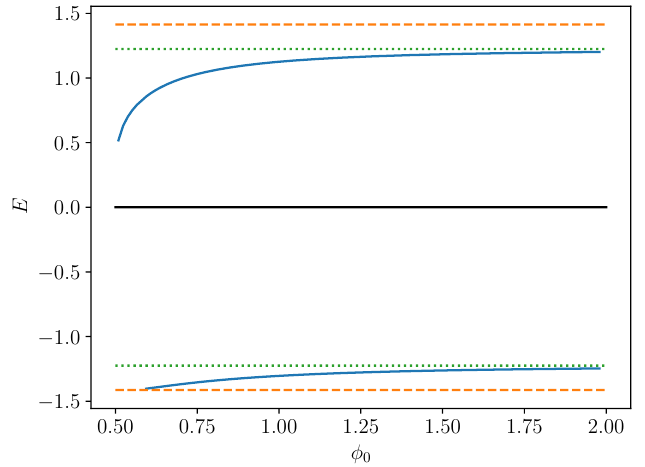
Figure 1 . Energy eigenvalues (solid curves) as a function of the parameter φ 0 . Dashed lines correspond to the threshold of the continuum spectrum E = analytical value obtained in the absence of back-reaction E = of results obtained in